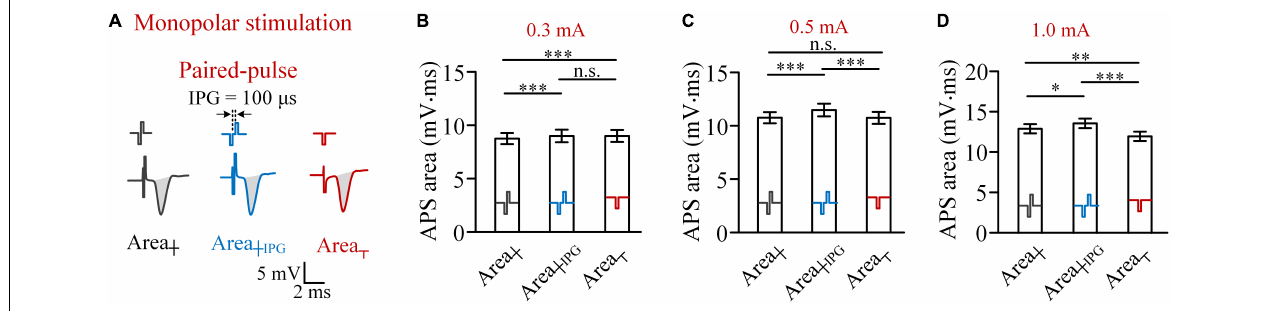
FIGURE 2 | Comparisons of areas of APS evoked by biphasic pulses and paired pulses, with an inter-phase gap of 100 µ s, and cathodic pulses in monopolar stimulations in rat experiments. (A) Examples of APS evoked by the three types of pulses. (B–D) Comparisons of mean APS areas evoked by the three types of pulses with pulse intensities of 0.3, 0.5, and 1.0 mA, respectively ( ∗ p < 0.05, ∗∗ p < 0.01, ∗∗∗ p < 0.001; n.s., not significant, two-way ANOVA, post hoc least significant difference test, n =